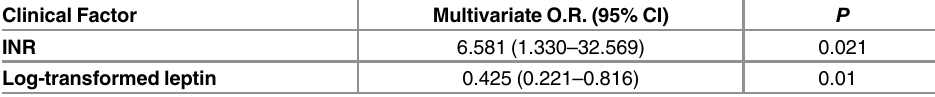
Table 4. Multivariable stepwise logistic regression analysis for factors associated with malnutrition. Clinical